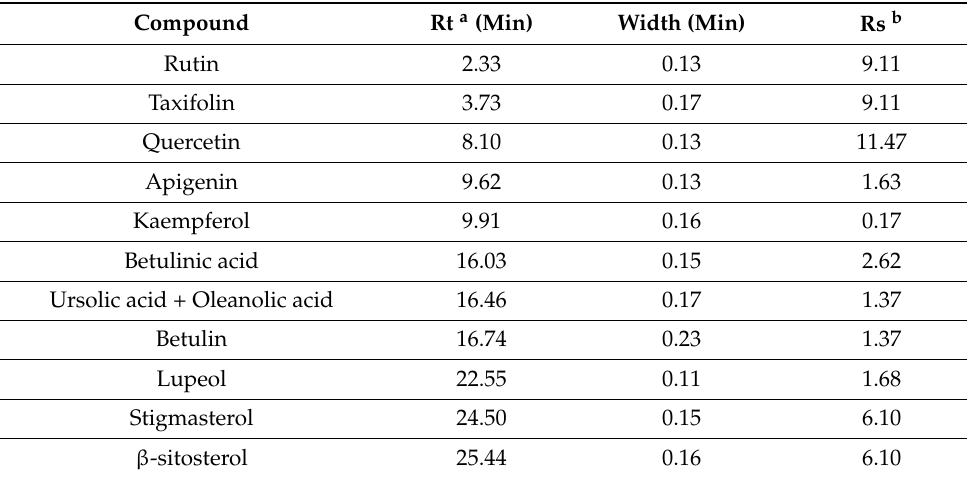
Table 2. Chromatographic features on the optimized gradient